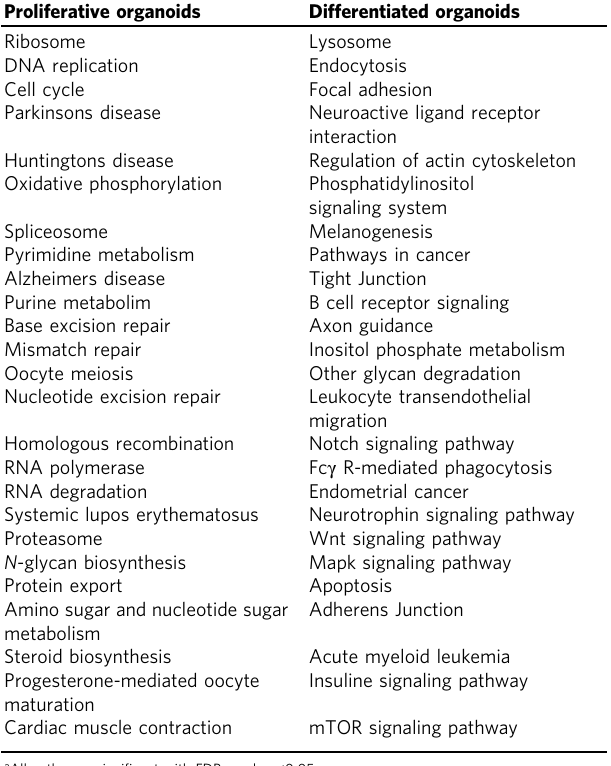
Table 1 GSEA showing the top 25 pathways (Kyoto Encyclopedia of Genes) signi fi cantly enriched